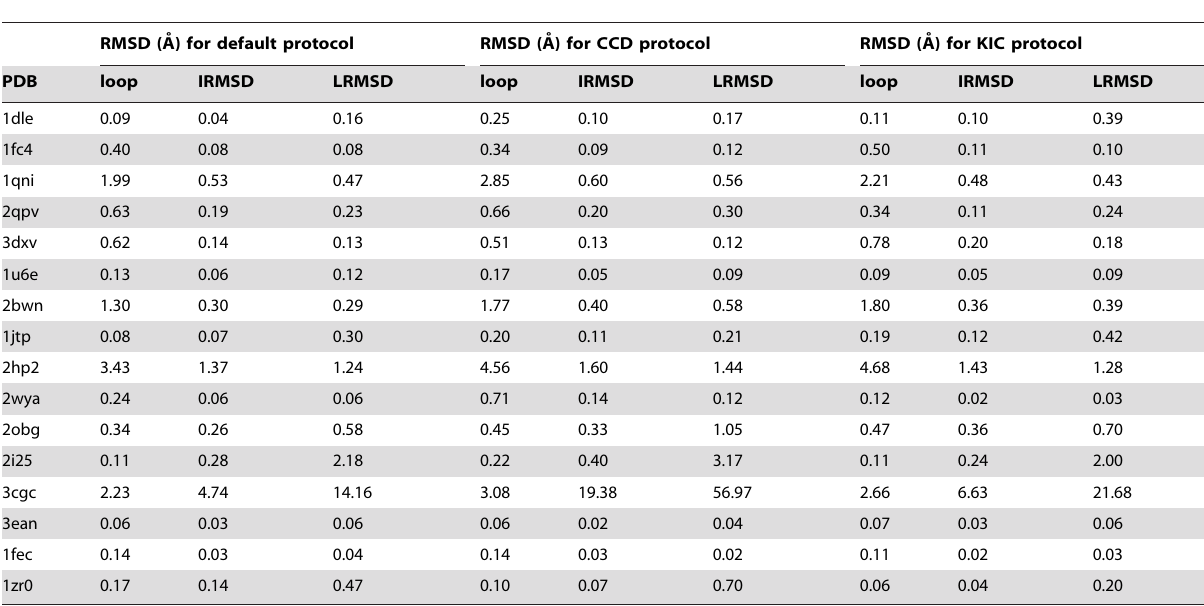
Table 4. Comparison of loop closure methods.